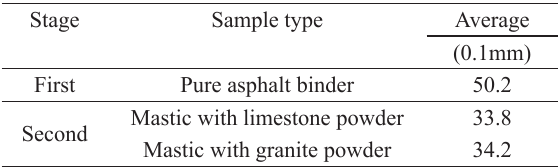
Results for the penetration